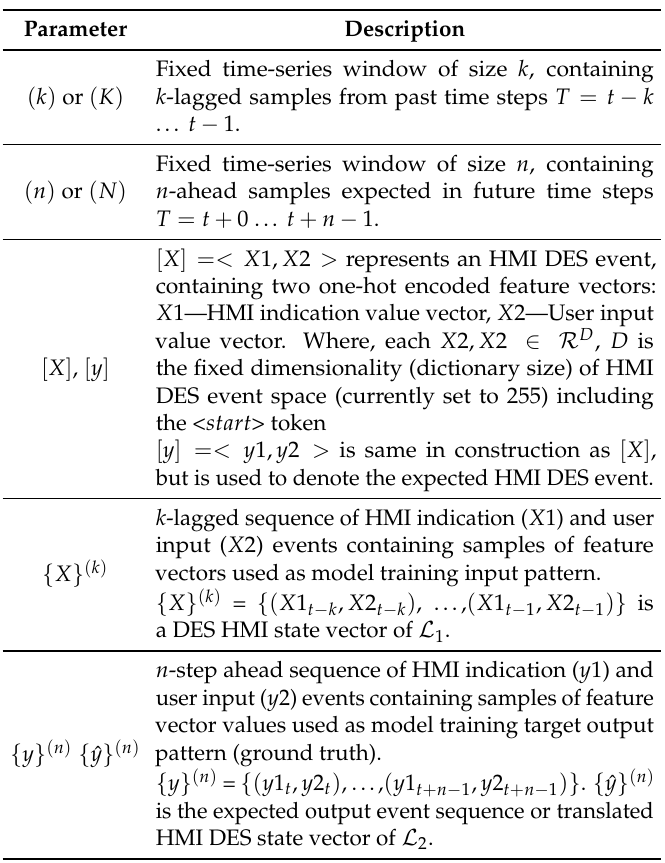
Table 1. Model Parameter